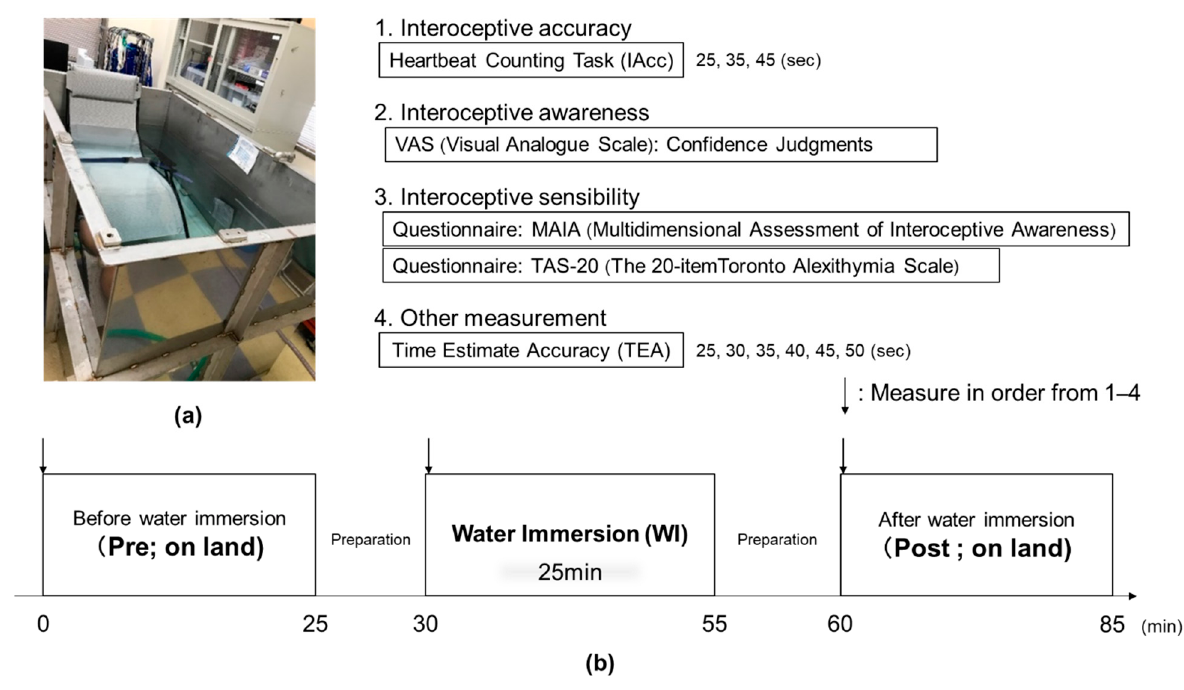
Figure 1. Experimental protocol in this study. ( a ) Reclining armchair in water ( b ) The above shows the interoceptive measurements (1–4) and bottom shows Protocol.